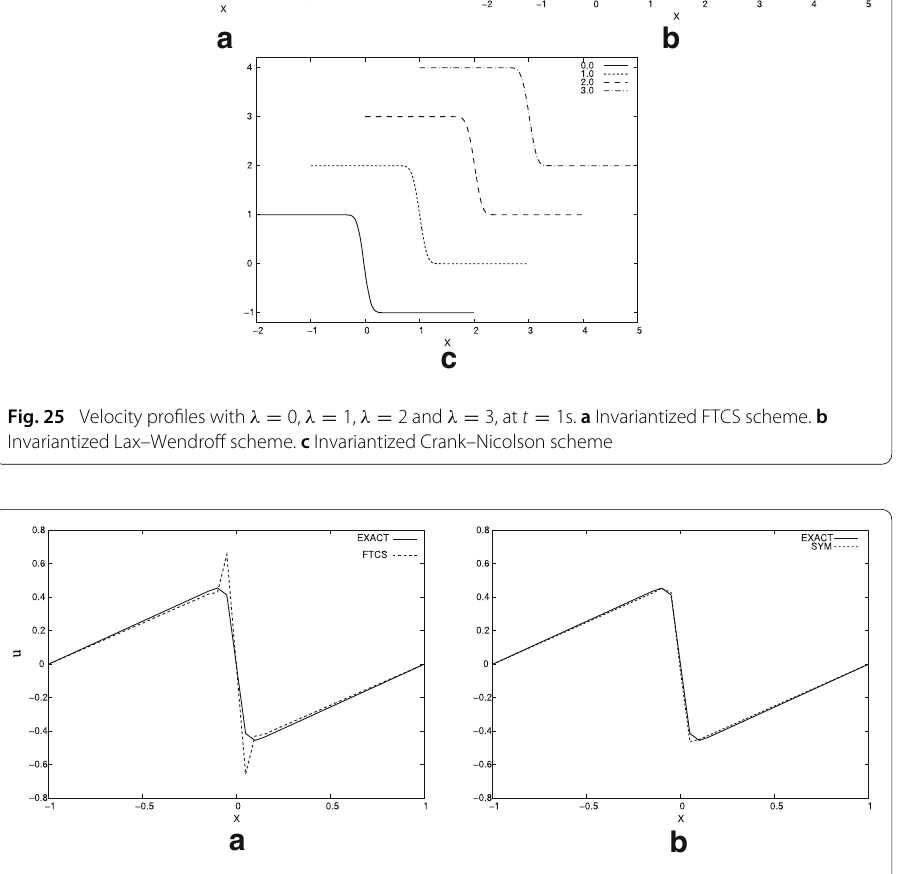
Fig. 26 Numerical solutions with ν = 10 − 2 , (cid:7) t = 5 . 10 − 2 , (cid:7) x = 5 . 10 − 2 , t = 2s. Self-similar case. a Standard FTCS scheme. b Invariant FTCS